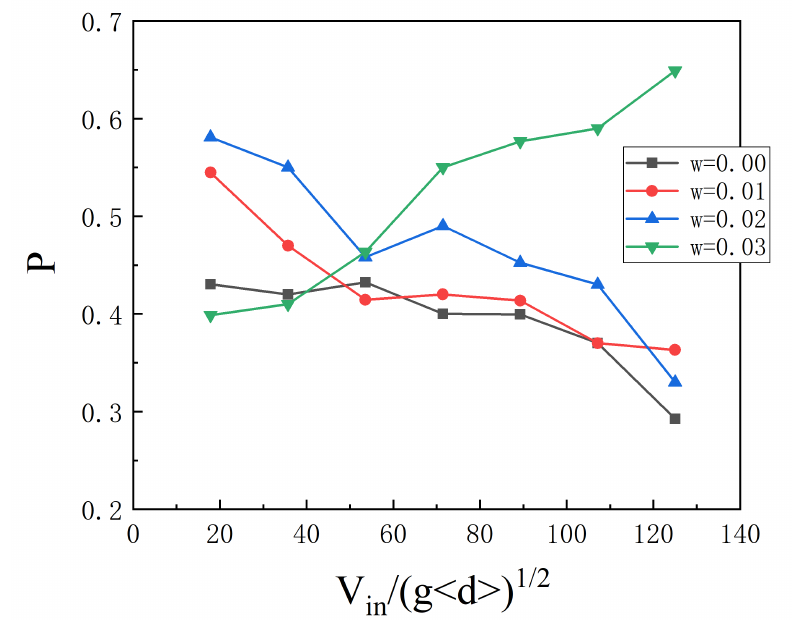
Figure 7. The energy dissipation in the sand-bed collision under different surface moisture values, and P is the ratio of the kinetic energy of all the grains before and after the